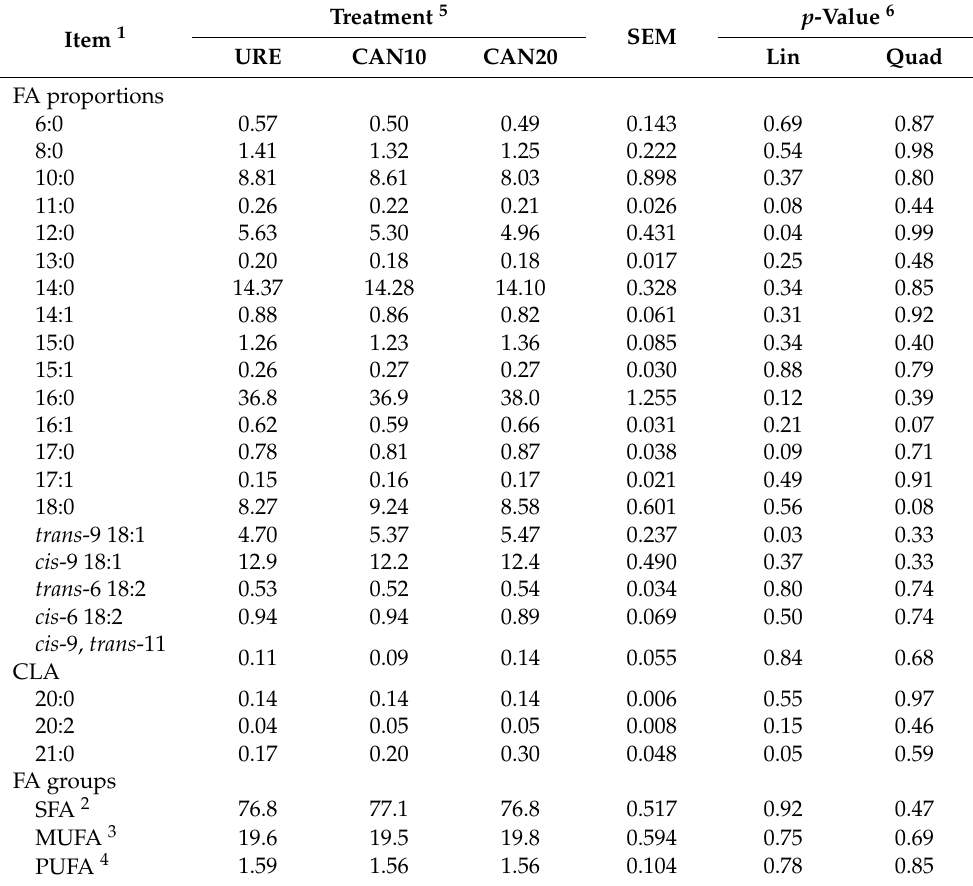
Table 4. Effects of calcium-ammonium nitrate (CAN) fed to lactating dairy goats on milk fatty acid (FA) profile.